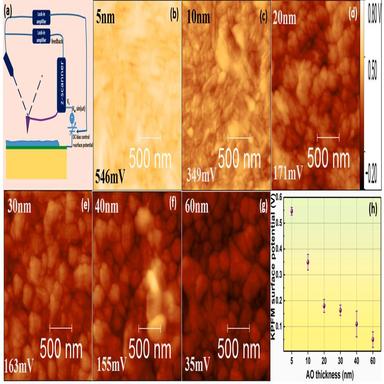
The KPFM surface potential analysis of AO of various thickness (a) the universal principle schematic of KPFM working; Surface potential measurement of (b) 5 nm (c) 10 nm (d) 20 nm (e) 30 nm (f) 40 nm (g) 60 nm (h) graph depicting various values with error bars.